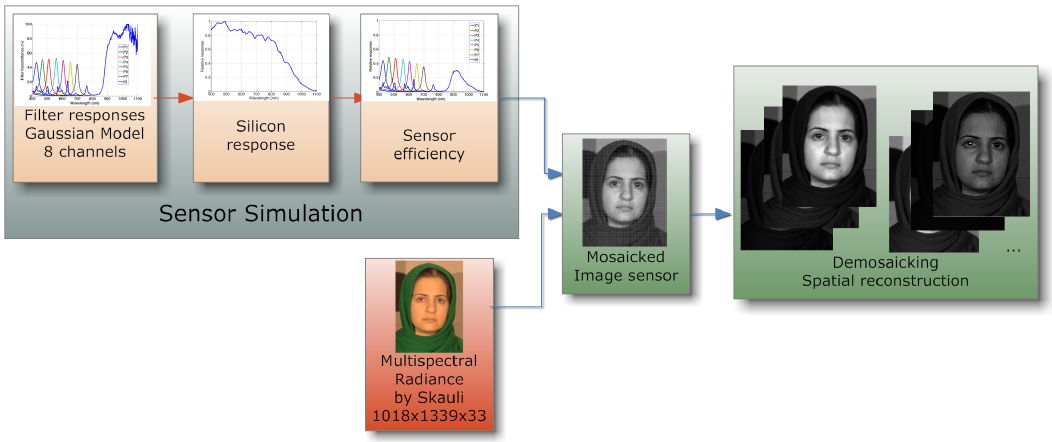
Figure 16. Simulation scheme of multispectral filters. The sensor system (photoreceptor and filters) is simulated using a particular illuminant and the silicon response of our